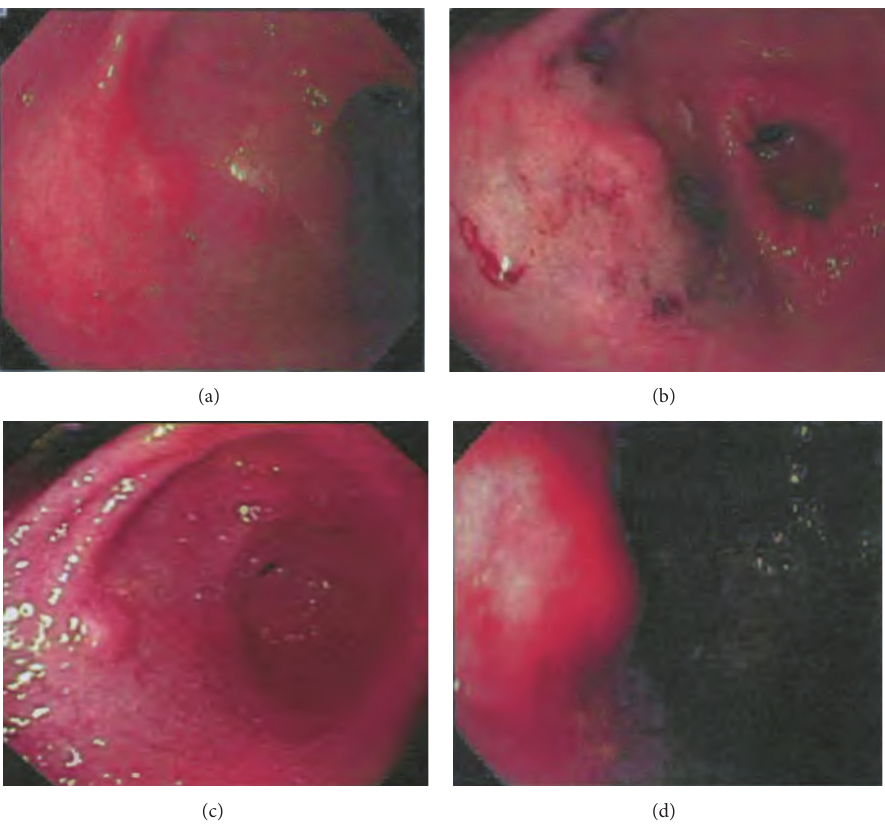
Figure 1: Esophagogastroduodenoscopy showing a submucosal nodule in gastric antrum.